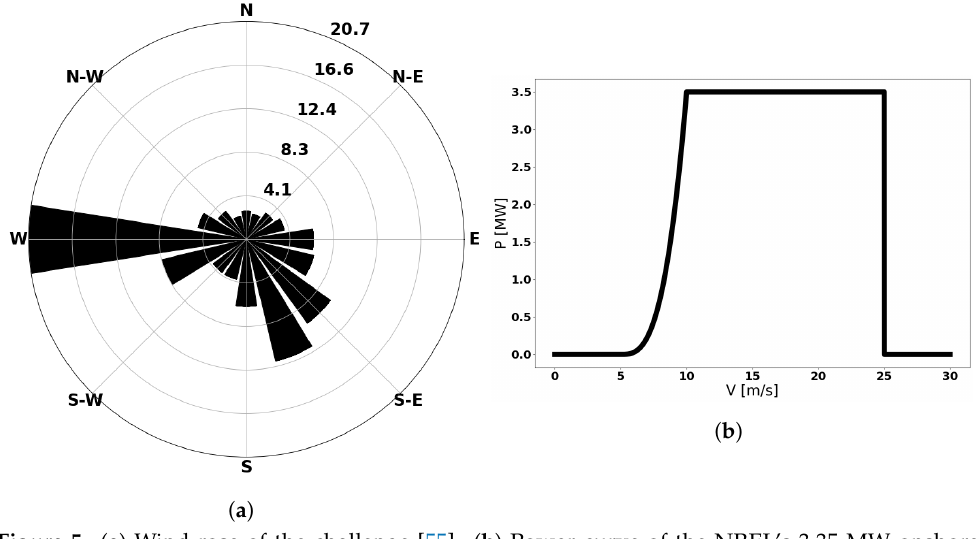
Figure 5. ( a ) Wind rose of the challenge [55]. ( b ) Power curve of the NREL’s 3.35-MW onshore reference turbine